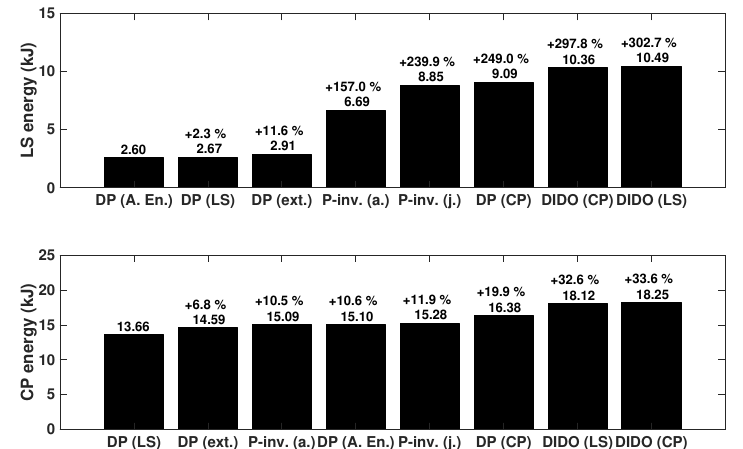
Figure A4. Horizontal path energy consumption replicated using middle feasible extension cylinder length at the beginning of the path.